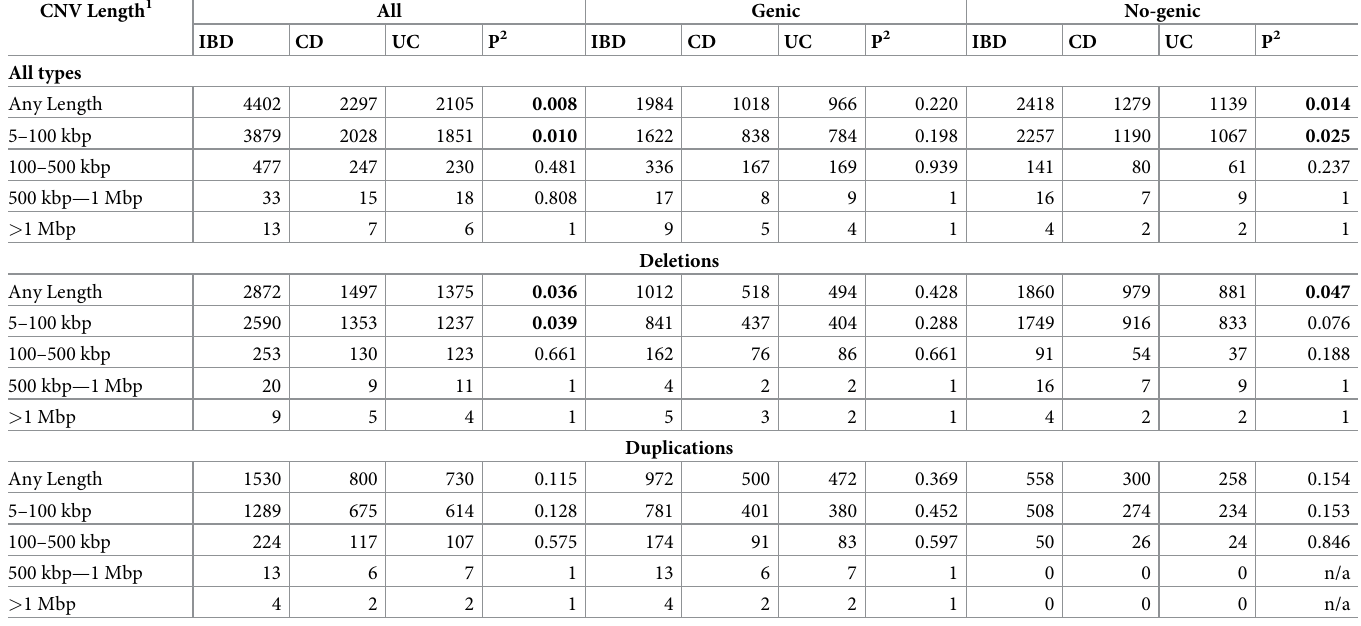
Table 1. All CNVs, genic CNVs and no genic CNVs of different lengths observed in the samples from CD and UC populations. Summary data for all CNV types and separated data for deletions and duplications are provided. CNV Length